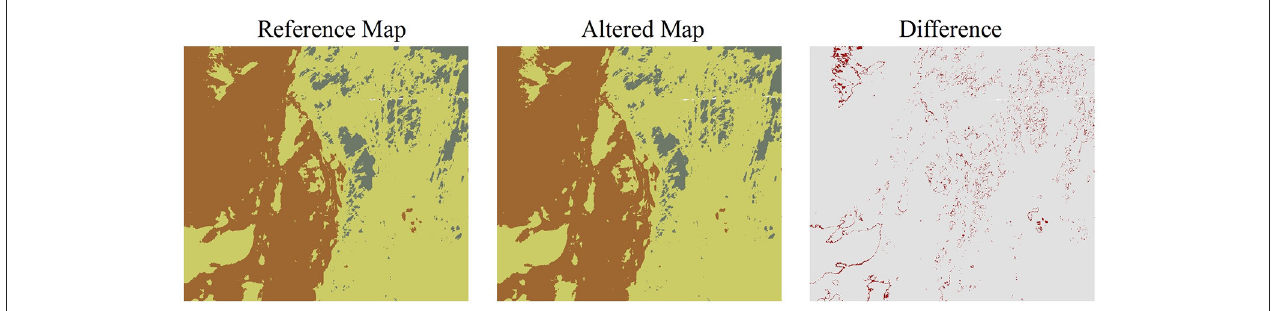
FIGURE 2 | Example of how different methods can produce different outcomes. The input data were bathymetric data, backscatter data, and topographic data (i.e., slope, easterness, northerness, and relative deviation from mean value) (see Lecours et al., 2016b). The area shown is a 13.4 km by 12 km subset of the German Bank study area presented in Brown et al. (2012) and Lecours et al.